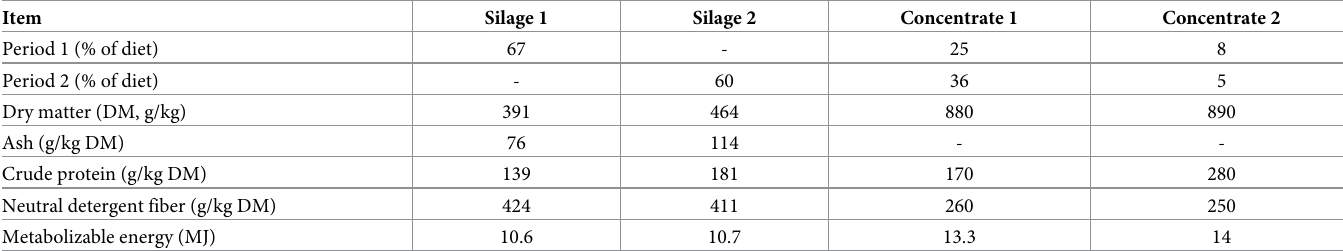
Table 2. Chemical composition of silage and